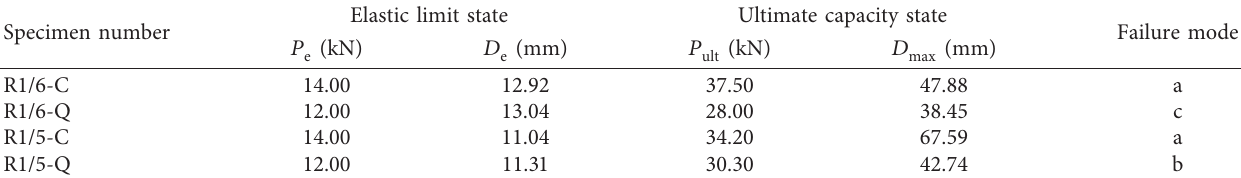
Table 3: Experimental